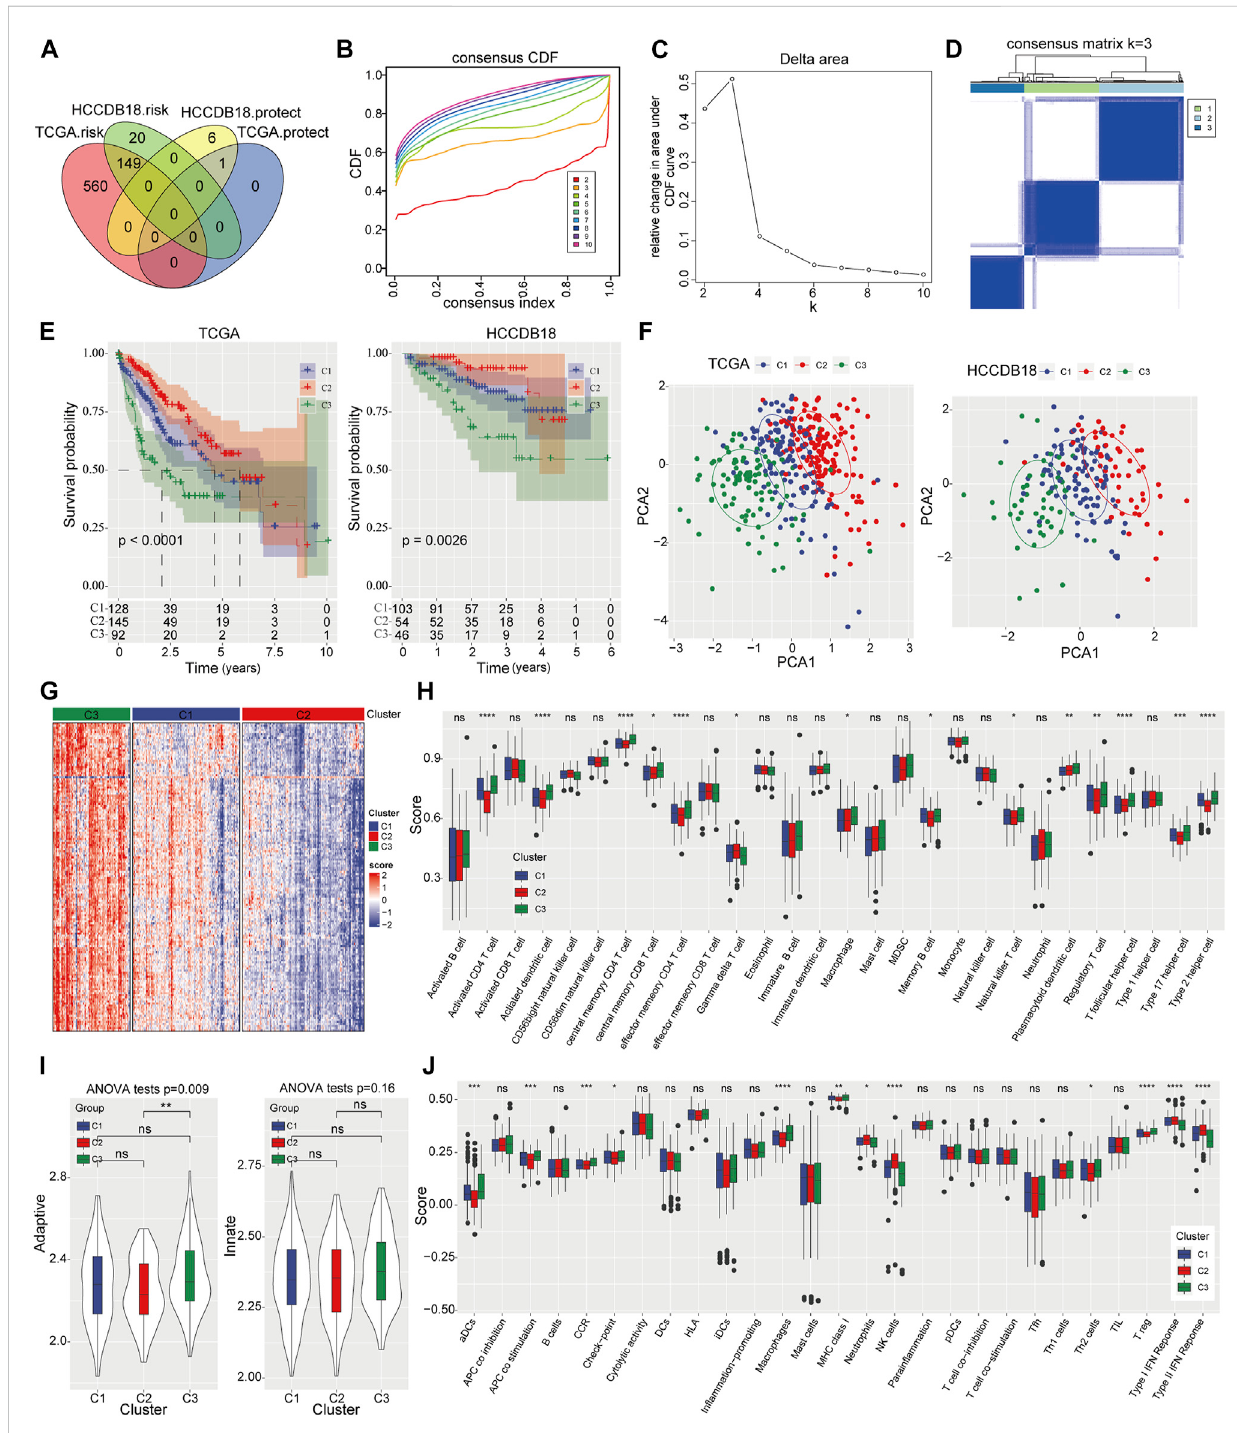
FIGURE 2 Identi fi cation of three PRMT related subtypes of HCC and immune status evaluation (A) The Venn diagram shows the PRMT-related genes with potential prognostic value that coincide between the TCGA-LIHC project and the HCCDB18 dataset. (B, C) The CDF curve trend and Delta area with k at 2 – 10. (D) Cluster heat map for consensus matrix with k = 3. (E) The Kaplan-Meier analysis among three molecular subtypes in TCGA-LIHC cohort and HCCDB18 cohort. (F) The distribution of consensus clusters by PCA. (G) Heat map represents enrichment score distribution of immune genes in three HCC subtypes. (H) The content of 28 immunecells quanti fi edby ssGSEA inthree HCC subtypes. (I) The difference ofadaptive immunity and innate immunity among the three subsets. (J) The enrichment degree of 29 immune signatures in three